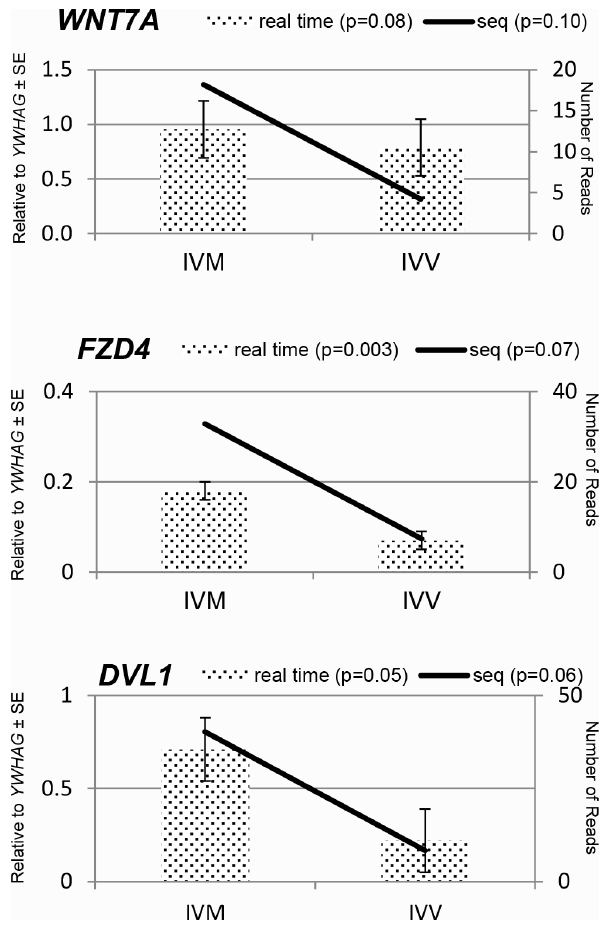
Figure 1. Real time PCR validation of Illumina sequencing data for WNT7A , FZD4 and DVL1 .